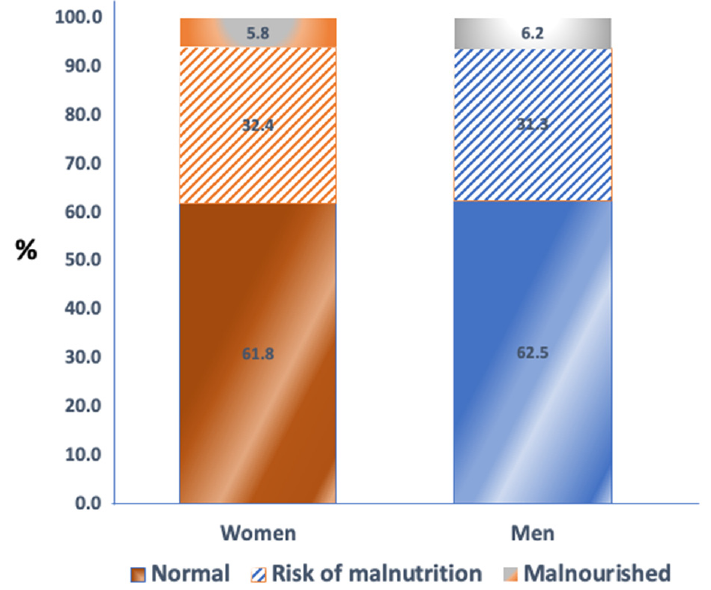
Figure 1. Distribution (%) of women and men according to nutritional status based on the Mini Nutritional Assessment (MNA) questionnaire.